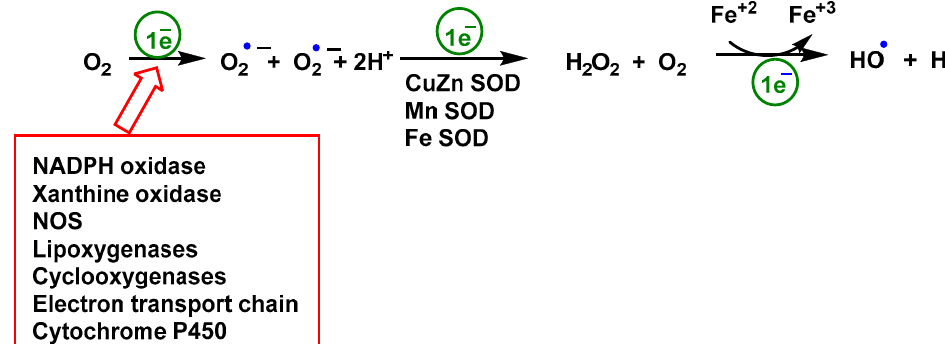
Figure 3. Chemical and enzymatic reactions generation of ROS. Reduction of O 2 produces • O 2 − , it is the precursor for all other ROS subspecies. Rapid dismutation of superoxide to peroxide allows its further conversion to OCl by myeloperoxidase MPO [92] or by Fe 3+ to • OOR or • OH. The Fenton reaction, in which peroxide is oxidized by Fe 3+ with • OH as a reactive intermediate, rarely occurs in cells. O 2 is rarely excited to 1 O 2 by radiation in mammals.